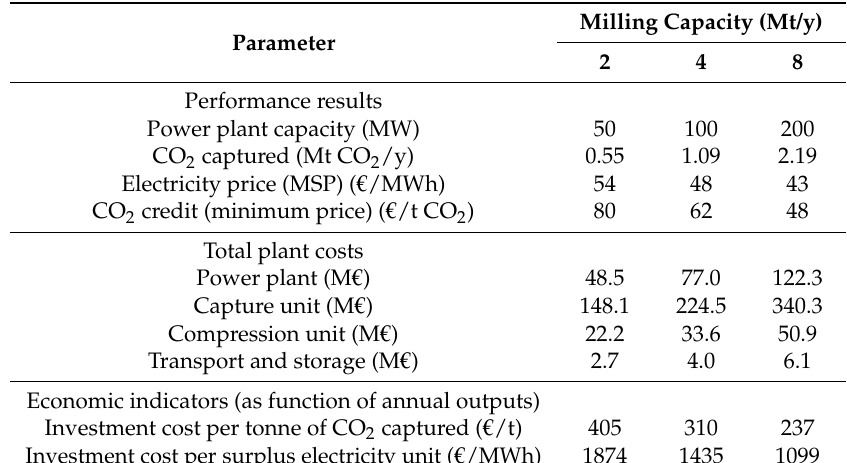
Table 6. Total investment costs and economic performance results for different milling